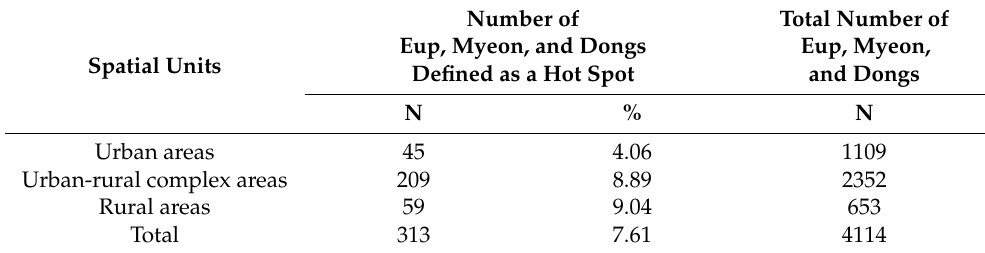
Table 7. Number of Eup, Myeon, and Dongs defined as a hot spot in urban areas and rural areas.